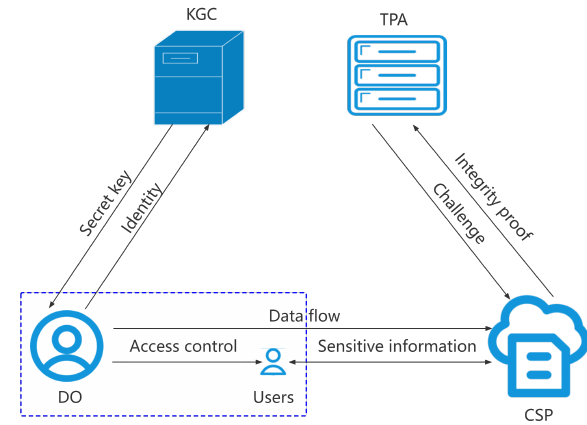
Figure 1. System